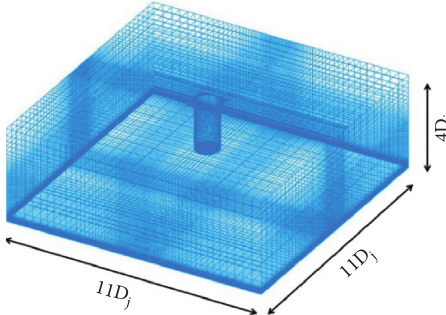
Figure 1: Mesh scheme 1 and the computational domain for the flat